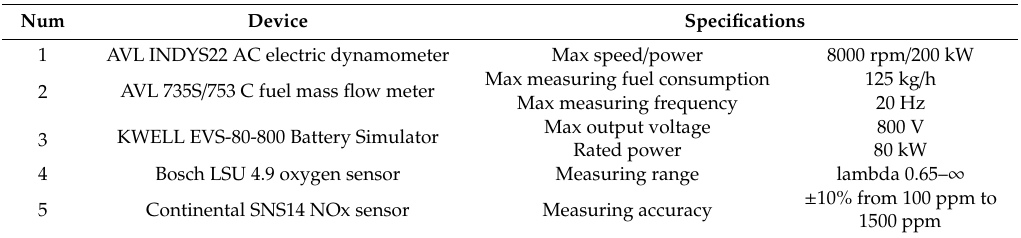
Table 3. Specifications of test bench.